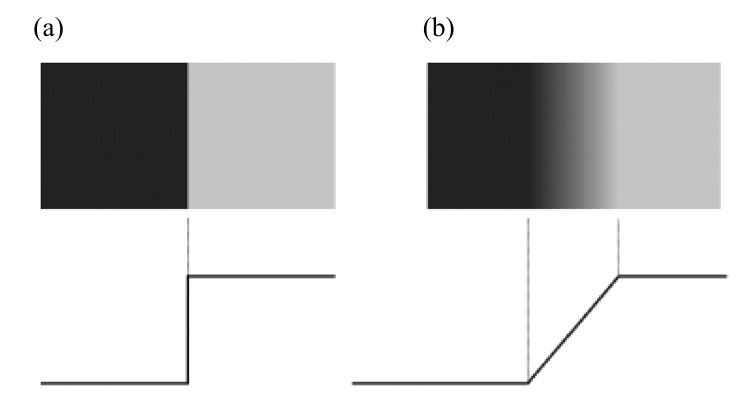
Fig. 1. Step (a) and ramp (b) models for edge